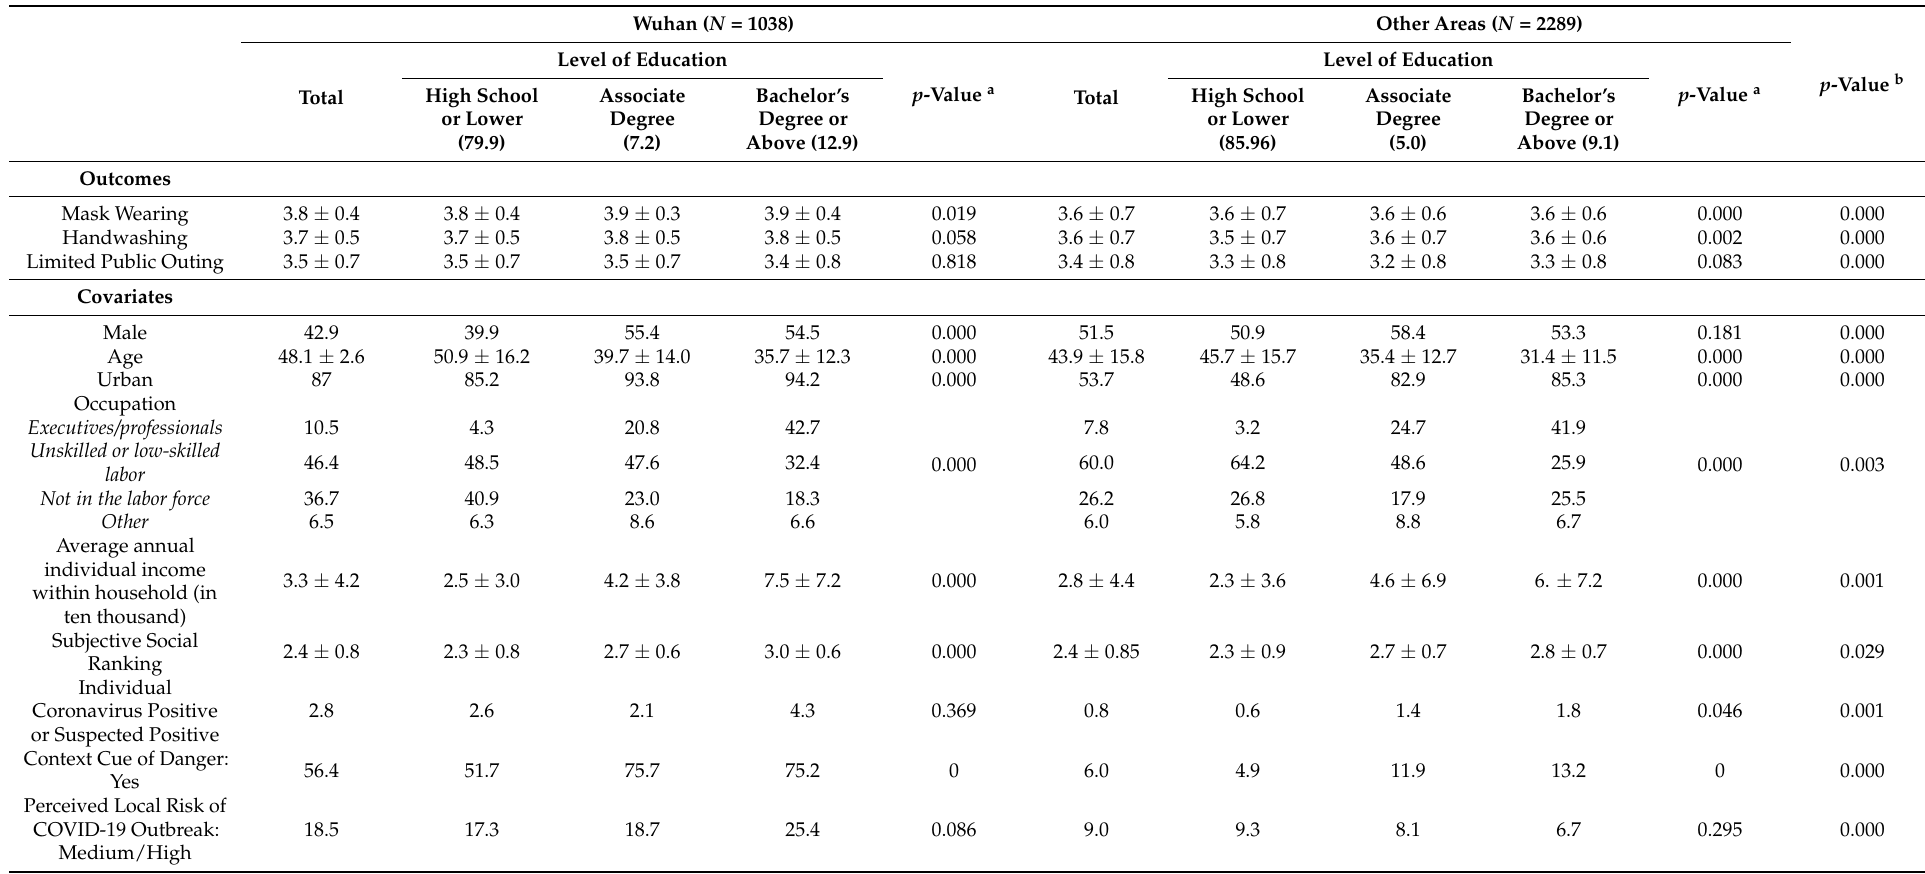
Table 1. Weighted mean ± sd or % of the study sample, The Chinese Survey of COVID-19 Impacts 2020 ( N = 3327).